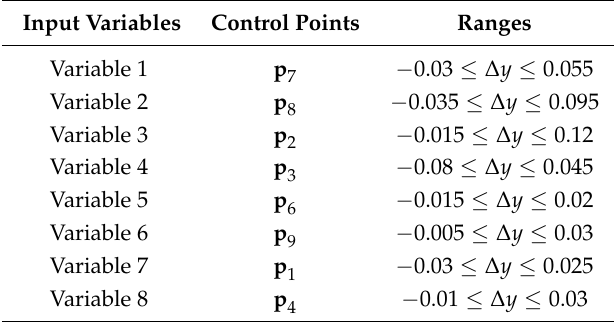
Table 2. Upper and lower limits of the eight movable control points that are the geometric input variables at the prediction accuracy tests and optimization